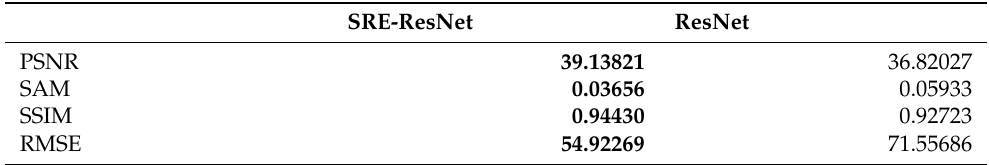
Table 3. Quantitative fusion results of SRE-ResNet and ResNet for Dataset